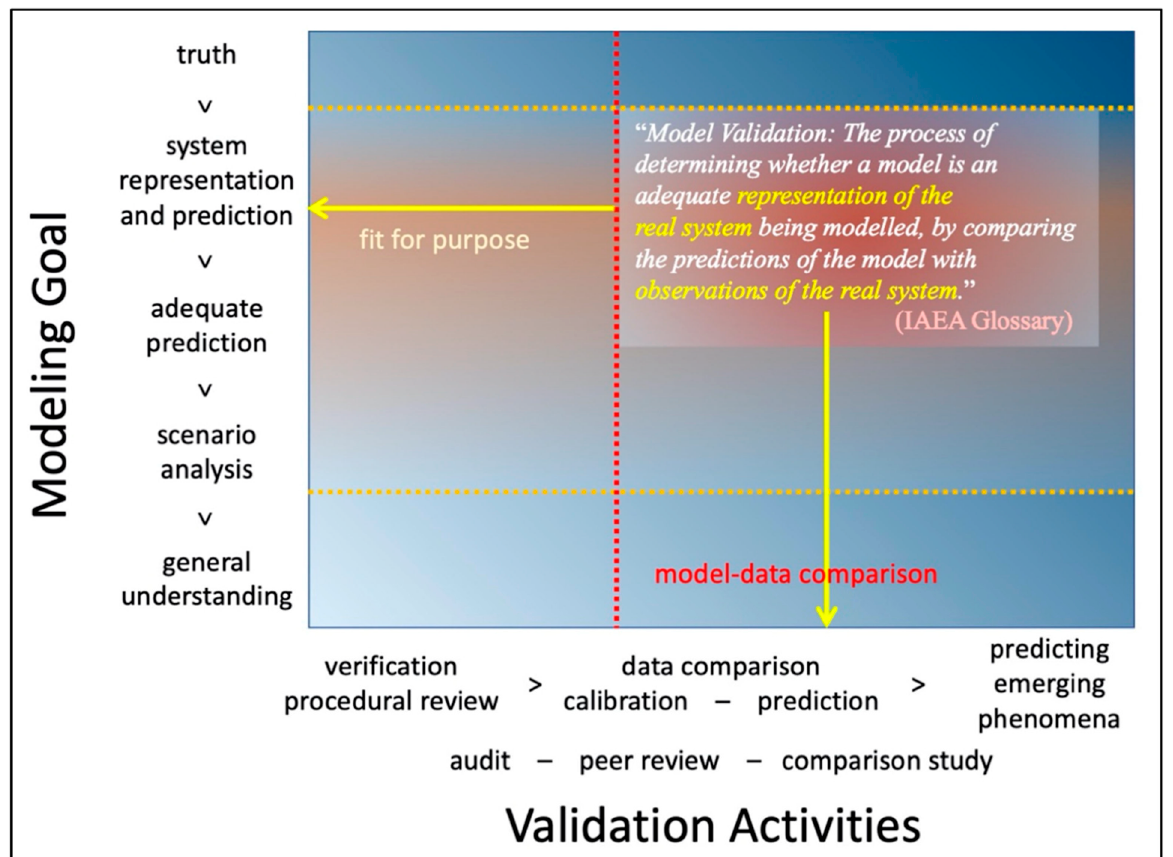
Figure 7. Approximate relation between validation activities needed to reach a particular validation goal. The yellow and red dotted lines indicate, respectively, the modeling goals and validation activities targeted by pragmatic model validation and the relation to the main goal and activity highlighted in the IAEA definition of model validation [29].